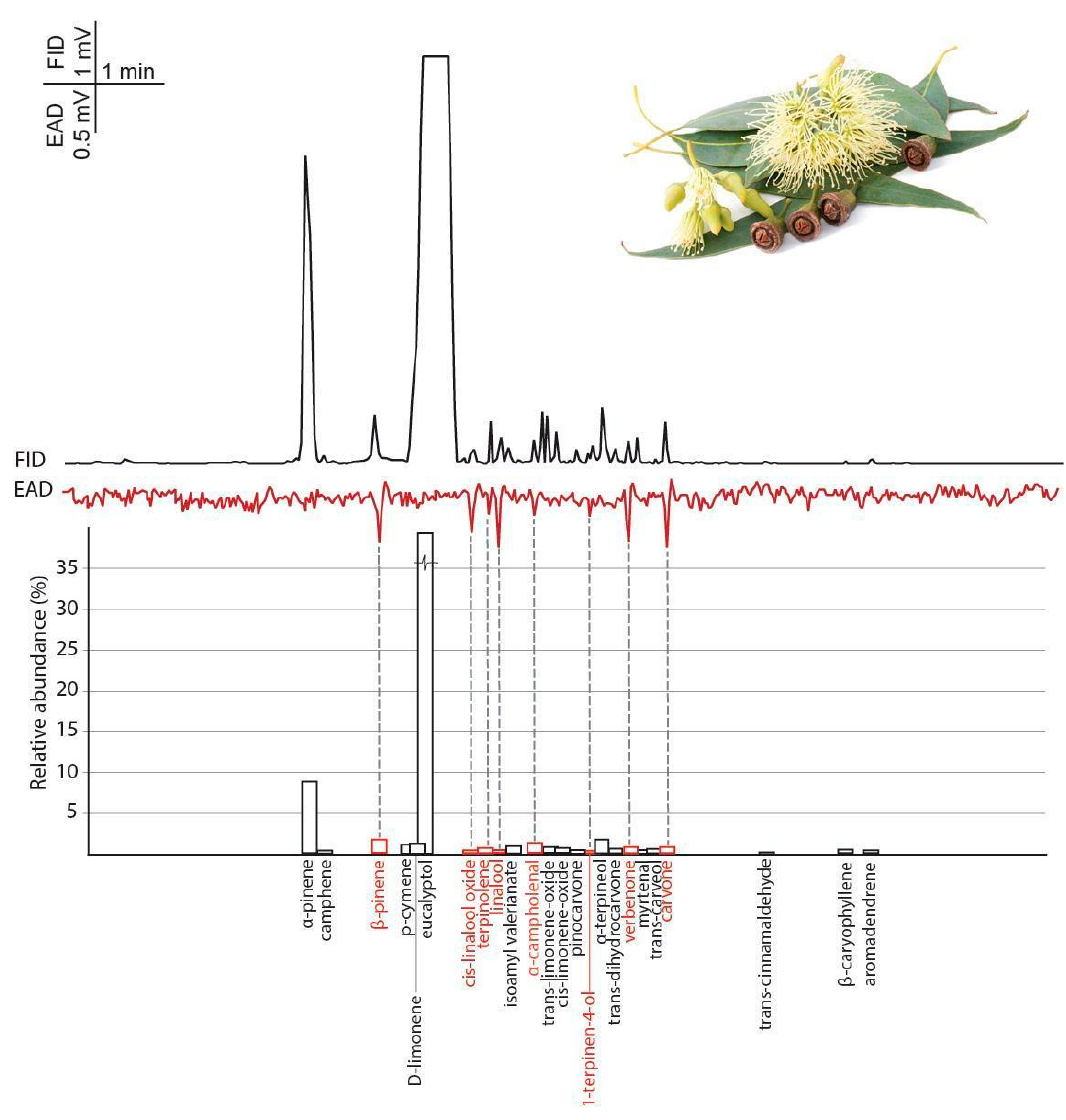
Figure 4. The averaged antennal response (EAD) of female box tree moths ( Cydalima perspectalis ) to eucalyptus essential oil headspace samples (collected with SPME) measured by gas-chromatography- coupled electroantennographic detection (GC-EAD) (n = 5). Bars indicate the relative abundance of volatile constituents based on GC-MS analysis. The names of antennal active volatiles are highlighted in red.